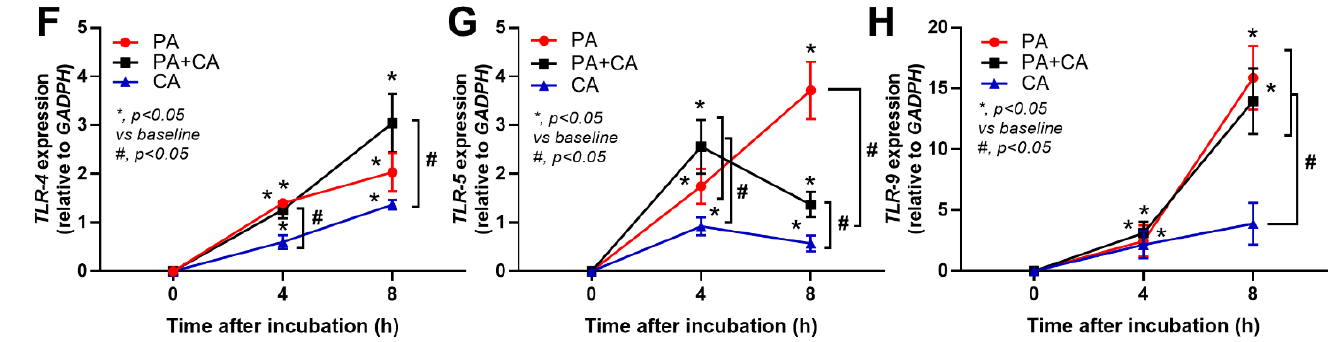
Figure 3. The responses of the pulmonary epithelial cells (NCI-H292) after activation by Pseudomonas alone (PA), Candida alone (CA), and Pseudomonas with Candida (PA+CA), as indicated by supernatant cytokines (TNF- α , IL-6, IL-10, IL-8, and IL-13) ( A – E ), along with the gene expression of TLR-4 , TLR-5 , and TLR-9 using polymerase chain reaction (PCR) ( F – H ) (independent experiments were performed in triplicate).